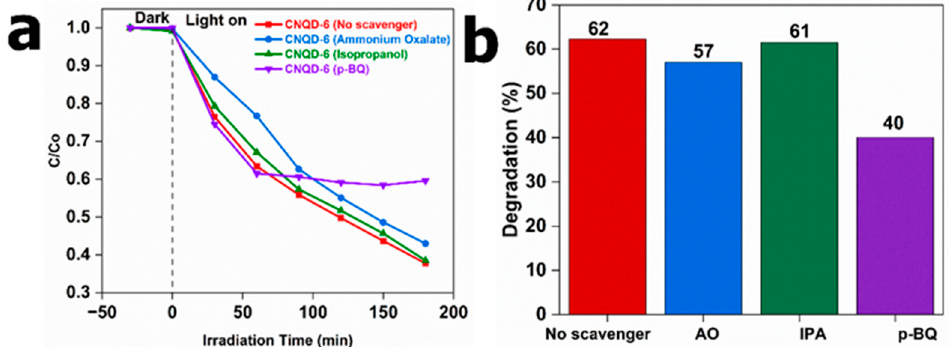
Figure 13. Photolysis of DCF with different scavengers (AO, IPA, and p -BQ) on degradation kinetics ( a ), and influence of scavengers on photocatalytic efficiency over bCN, CNS, and CNQD photocatalysts under visible light irradiation ( b ).